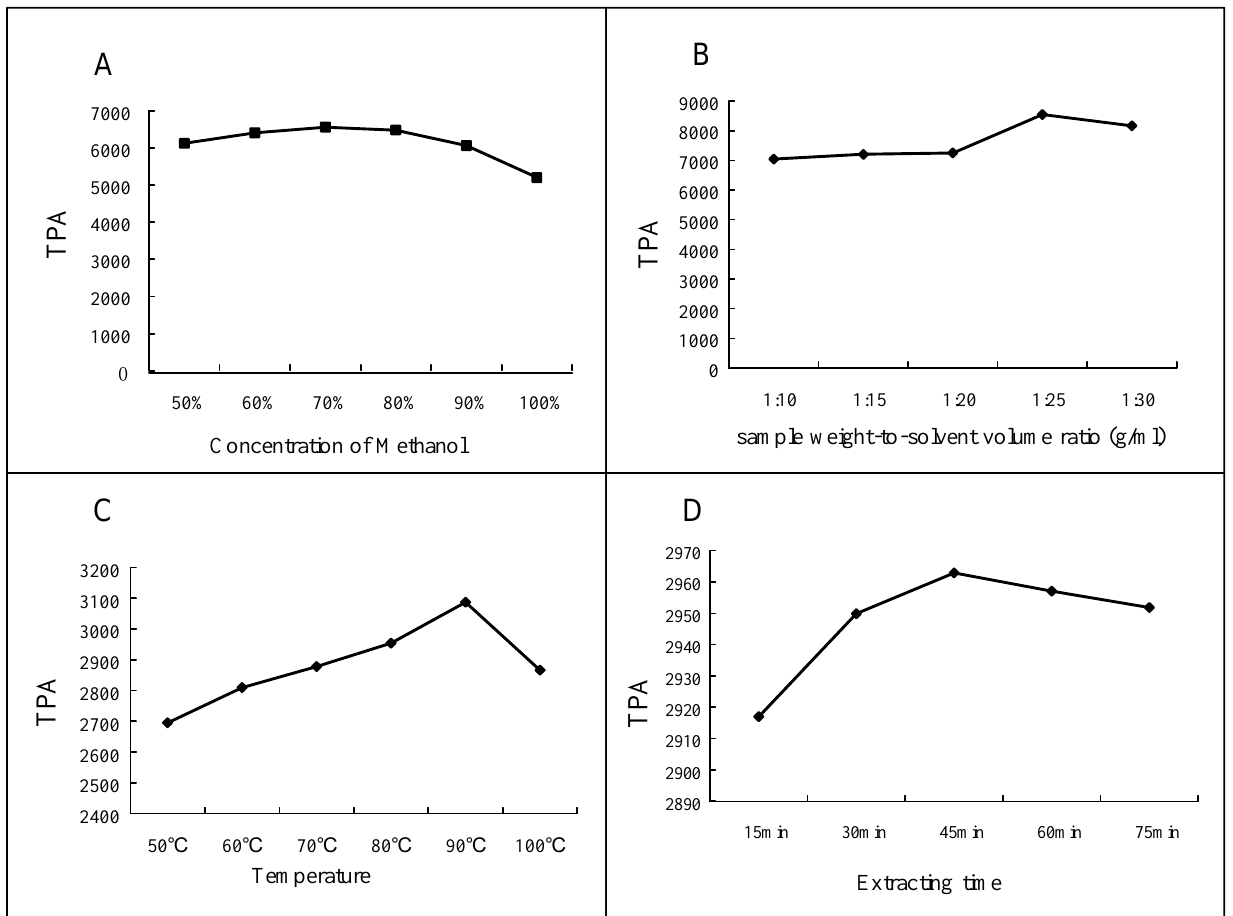
Figure 5. Results of optimization of sample extraction: assessment of methanol concentration (A); assessment of sample weight-to-solvent volume ratio (B); assessment of extraction temperature (C); assessment of extraction time